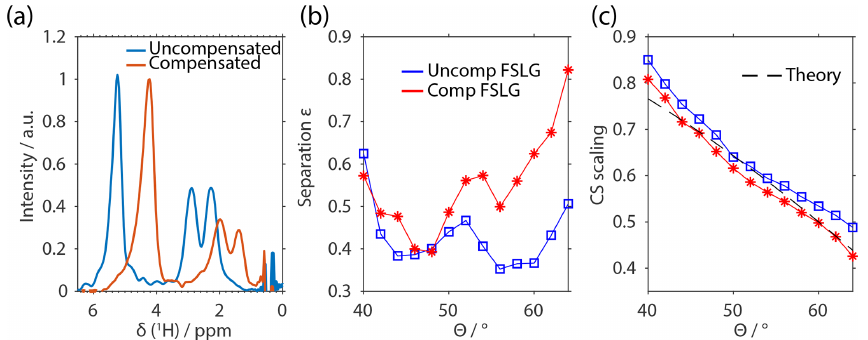
Figure 5. Experimental results of FSLG-based decoupling on U- 13 C- 15 N-glycine as a function of the effective-field angle. The spectra using rectangular pulses and compensated pulses during the FSLG block are shown in (a) with the effective-field angle set to the magic angle θ = θ m . The spectra are not processed in terms of chemical-shift scaling and referencing to illustrate the effect of implementing compensated pulses. The decoupling performance is analyzed in terms of the splitting between the two resonance lines of the CH 2 group (b) defined by the separation parameter ε and the chemical-shift scaling factor (c) . The MAS frequency was set to 14kHz with an effective field of 125kHz at an external magnetic field of 14.1T.